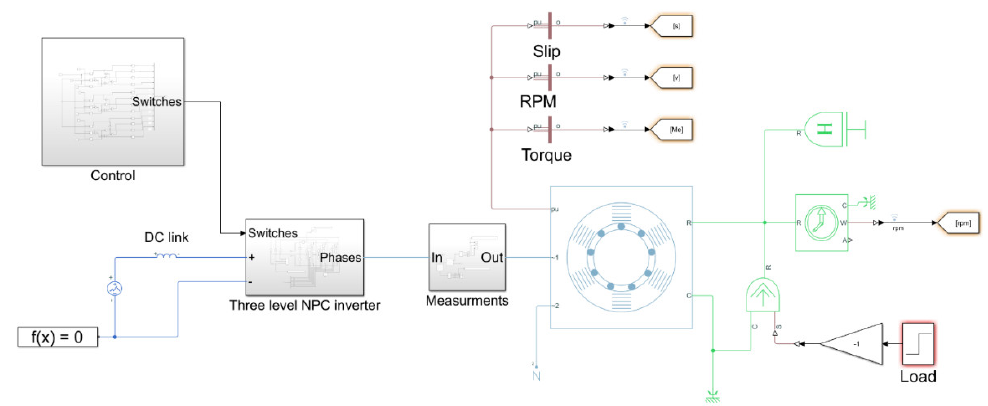
Figure 1. Simulation model of motor power drive.